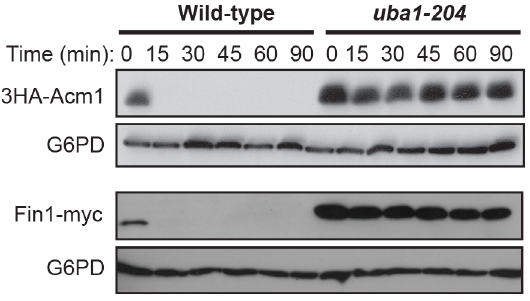
Figure 3. Acm1 proteolysis requires a functional ubiquitin conjugation pathway. Expression of 3HA-Acm1 or Fin1-myc was induced with galactose in G1-arrested wild-type (RJD3268) or uba1-204 (RJD3269) cells at room temperature. Culture temperature was increased to 37 u C prior to addition of glucose and cycloheximide. Cells were harvested at the indicated times after terminating expression and protein levels monitored by immunoblotting with anti-HA or anti-myc antibodies. G6PD is a loading